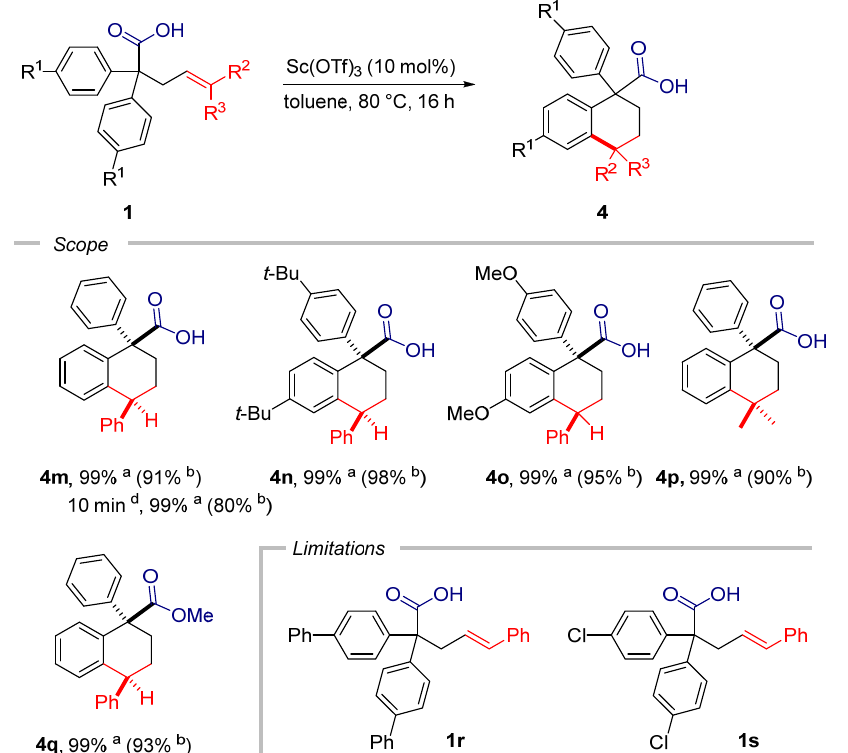
Figure 4. C -selective cyclization of δ -alkenoic acids featuring gem -electron-rich phenyl groups and a potential stabilized cation at the terminal position of the alkene. c a yields were determined by 1 H NMR using 1,3,5-trimethoxybenzene as internal standard; b isolated yields; c all reactions run under thermal conditions unless otherwise stated; d run under microwave conditions.